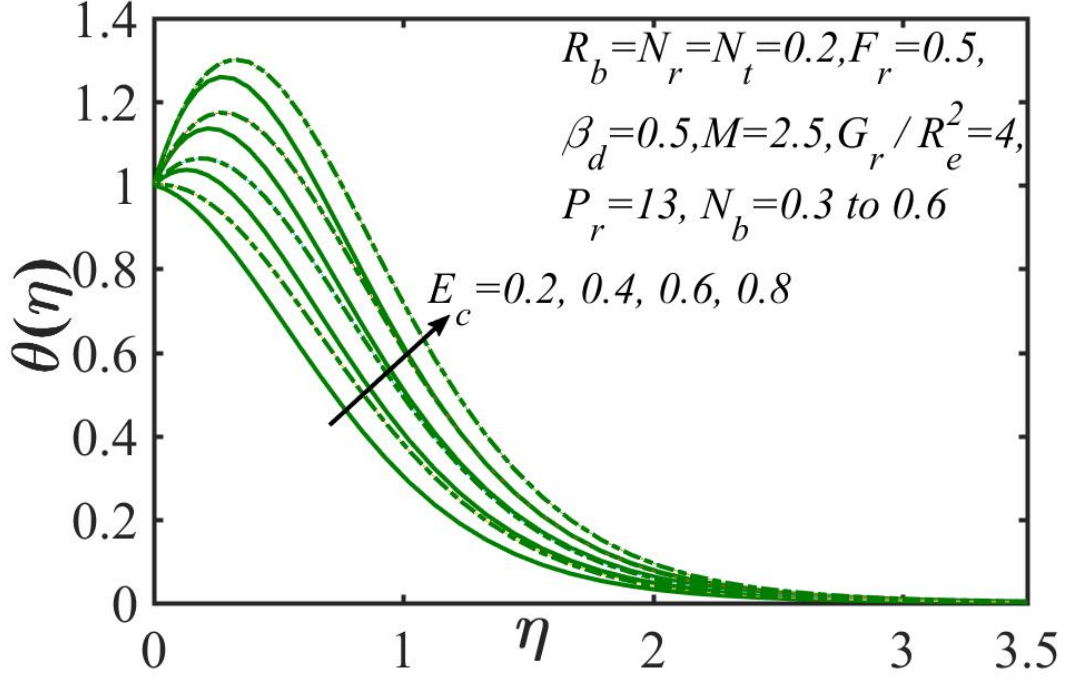
Figure 9. E ff ect of the Eckert number E c and the Brownian motion parameter “ N b ” on temperature Figure 9. Effect of the Eckert number (cid:1831) (cid:3030) and the Brownian motion parameter “ (cid:1840) (cid:3029) ” on temperature distribution. Solid line: N b = 0.3, Dotted line: N b = 0.6. distribution. Solid line: (cid:1840) (cid:3029) = 0.3 , Dotted line: (cid:1840) (cid:3029) = 0.6.